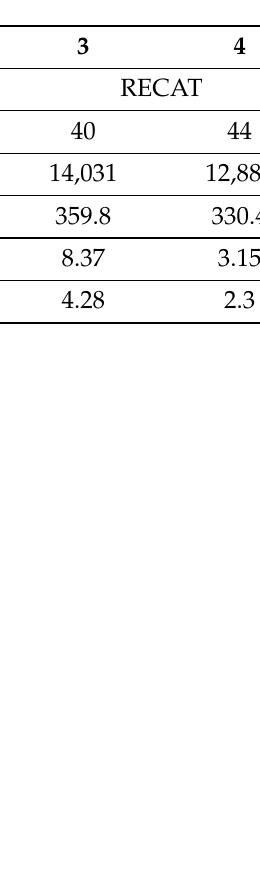
Table 11. Summary of en-route and takeoff delays [min/ac].